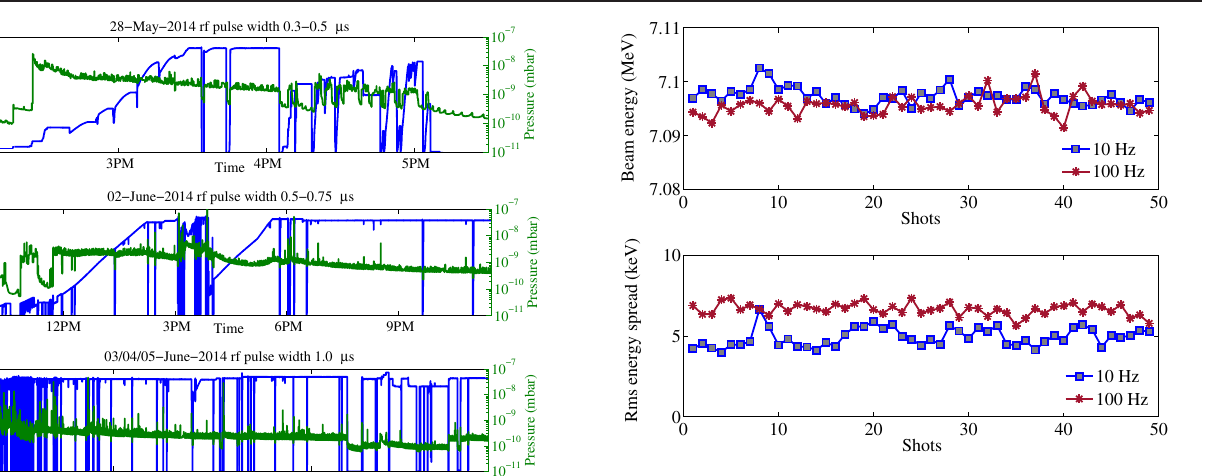
repetition rate of 10 Hz for rf running at 10 Hz and 100 Hz.